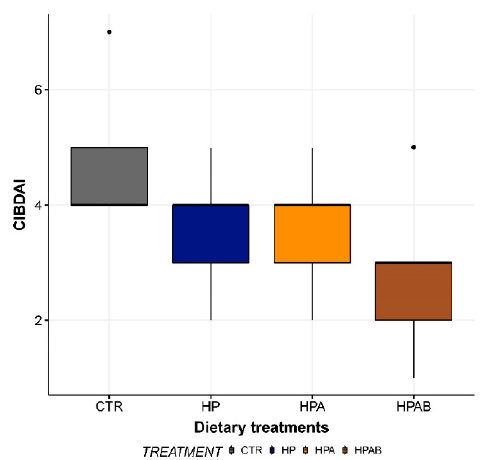
Figure 2. Canine Inflammatory Bowel Disease Activity Index (CIBDAI) score before the initiation of the study (CTR) and at the end of each dietary treatment. Data are represented as box and whisker plots showing median, quartiles, range, and outliers. CTR: Control diet; HP: Hydrolysed protein diet; HPA: Ascophyllum nodosum -supplemented HP diet; HPAB: B. subtilis C-3102 fortified HPA diet.